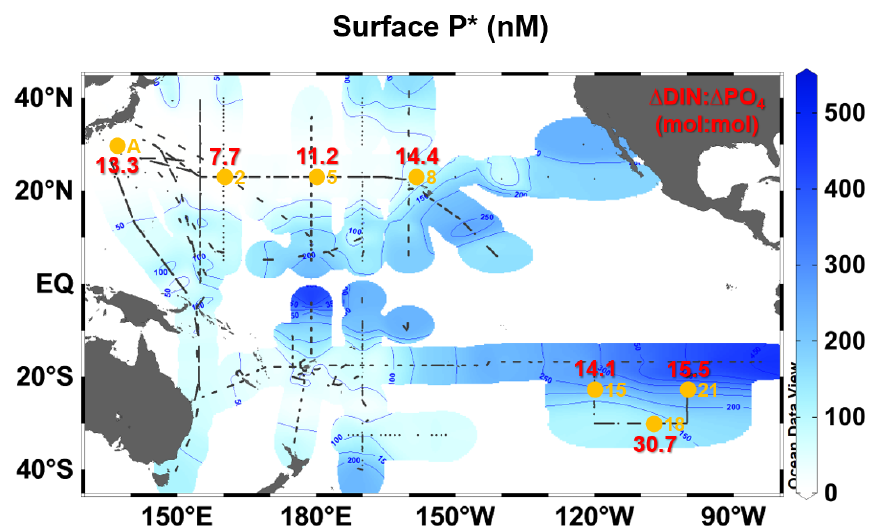
Figure 5. Surface distributions of P ∗ in the oligotrophic Pacific Ocean (40 ◦ N–40 ◦ S). The P ∗ data were derived from the assembled data on nanomolar concentrations ( < 1000nM) of PO 4 and N + N. Small black dots denote sampling stations for the nanomolar PO 4 and N + N. Large orange circles denote the stations where the incubation experiments were conducted. Red values indicate the experimentally determined (cid:49) DIN : (cid:49) PO 4 ratios (Table